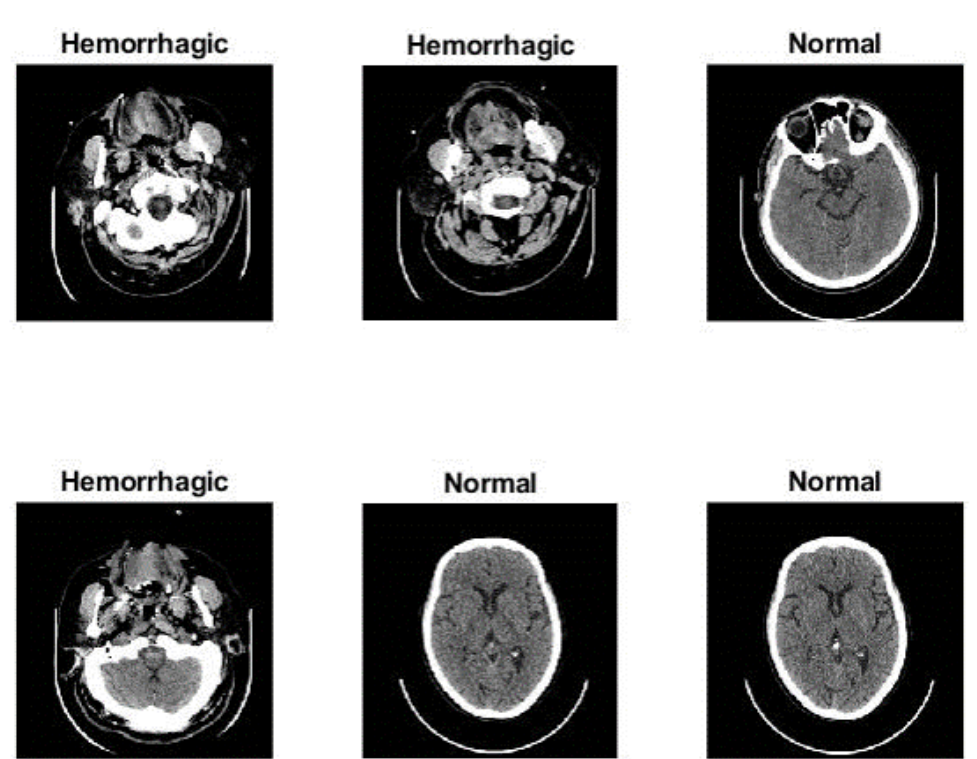
Figure 3. Set of CT images of a hemorrhage after image